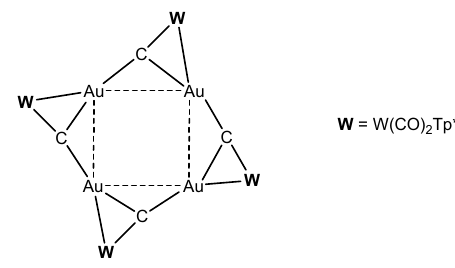
Figure 31. The [W] - C core. T* = tris(3,5-dimethylpyrazolyl)borate, [HB(pzMe 2 ) 3 ] − .